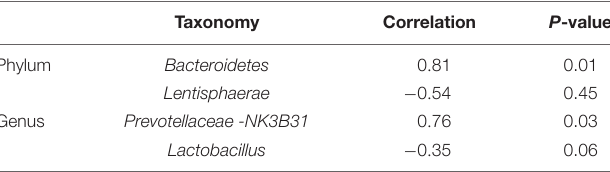
TABLE 2 | Pearson correlation analysis between cortisol level and differential microbe.